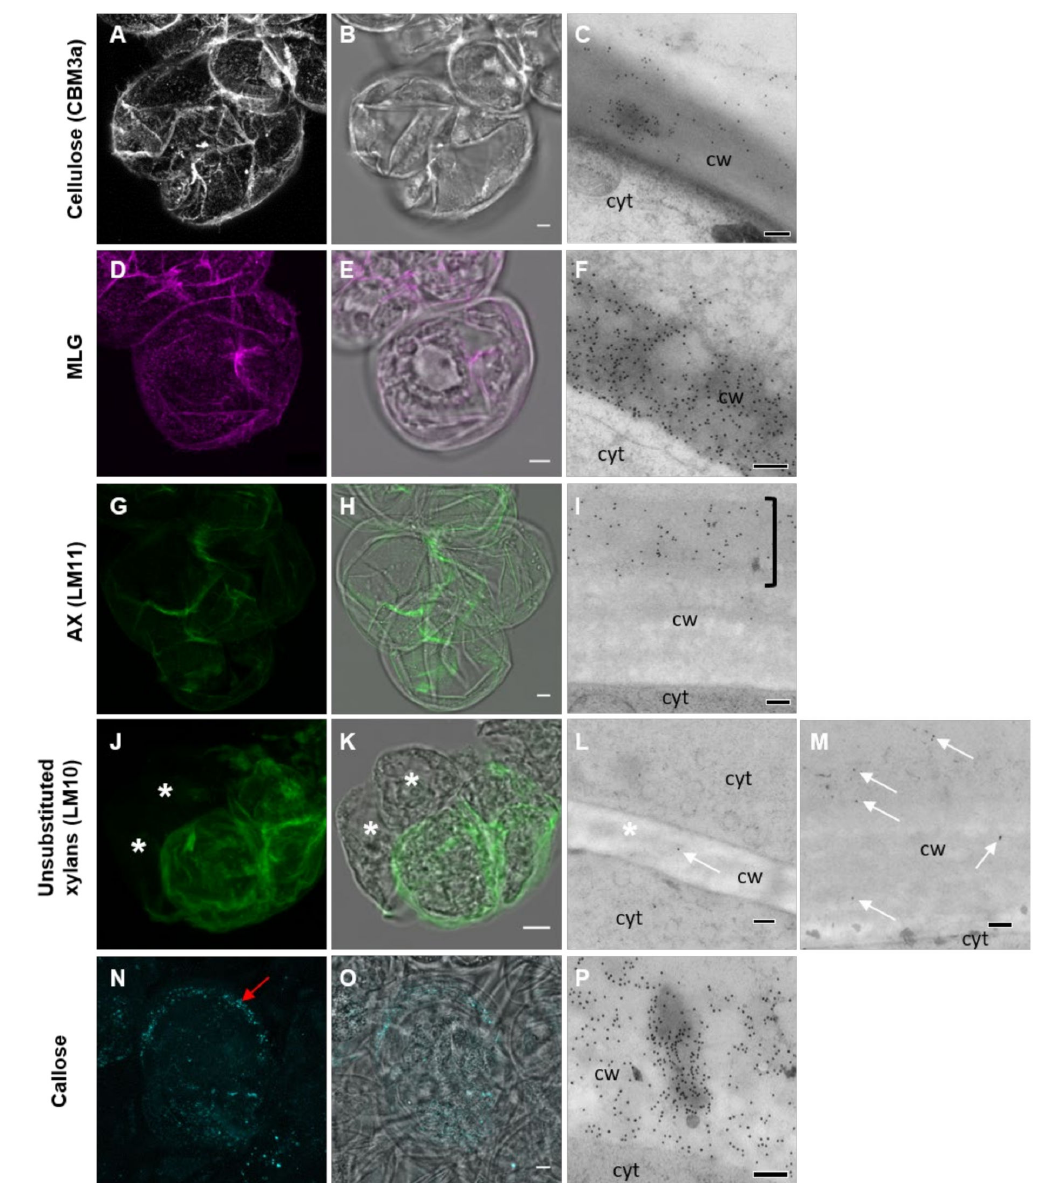
Figure 4. Fully developed cell walls of Lolium SCC from 7-day-old (do) cells labeled for cellulose, MLG, AX, the non- reducing end of xylans, and callose imaged using LSM ( A , B , D , E , G , H , J , K , N , O ) and TEM ( C , F , I , L,M , P ). Cellulose ( A – C ) covered the cell wall in a thick mat. MLG ( D – F ) was present in punctate dots and AX ( G – I ) formed filaments over the surface of the cell wall. In TEM sections, AX was observed to be present on the outer part of the cell wall away from the cytoplasm (bracket). Unsubstituted xylans ( J – M ) only became apparent in fully formed cell walls (arrows) and were not obvious in newly developing cell walls (asterisks). Note: The labeling density of LM10 was lower than most other antibodies. Callose ( N – P ) formed small patches around the edge of the cell (N; red arrow), which could be observed in TEM images (cw, cell wall and cyt, cytoplasm). Scale bars = 5 µ m ( A , B , D , E , G , H , J , K , N , O ) and 200 nm ( C , F , I , L , M , P